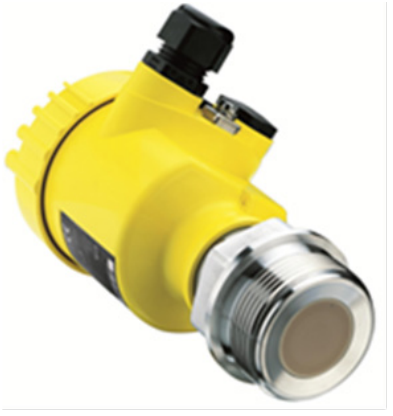
Figure 6: Measuring cell used in the